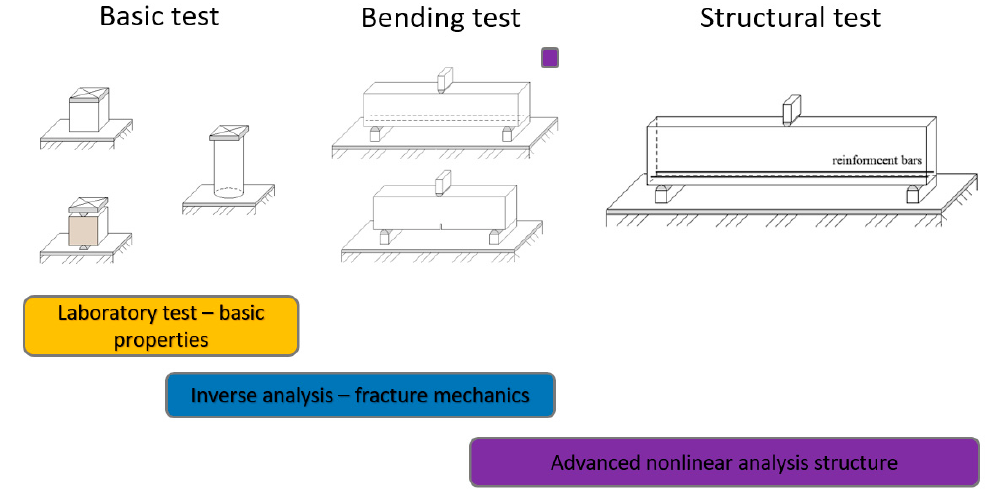
Figure 2. Experimental program: Basic test, bending test and structural test.